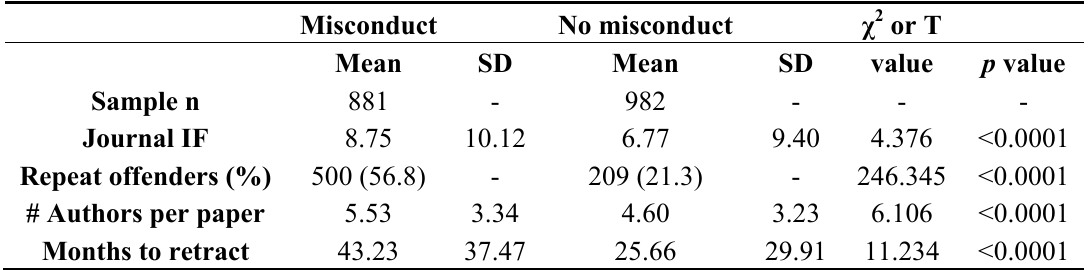
Table 2. Comparison of articles for which retraction was explained as a result of known or possible fabrication or falsification (“Misconduct”) vs. articles for which retraction was explained as the result of any other cause (“No